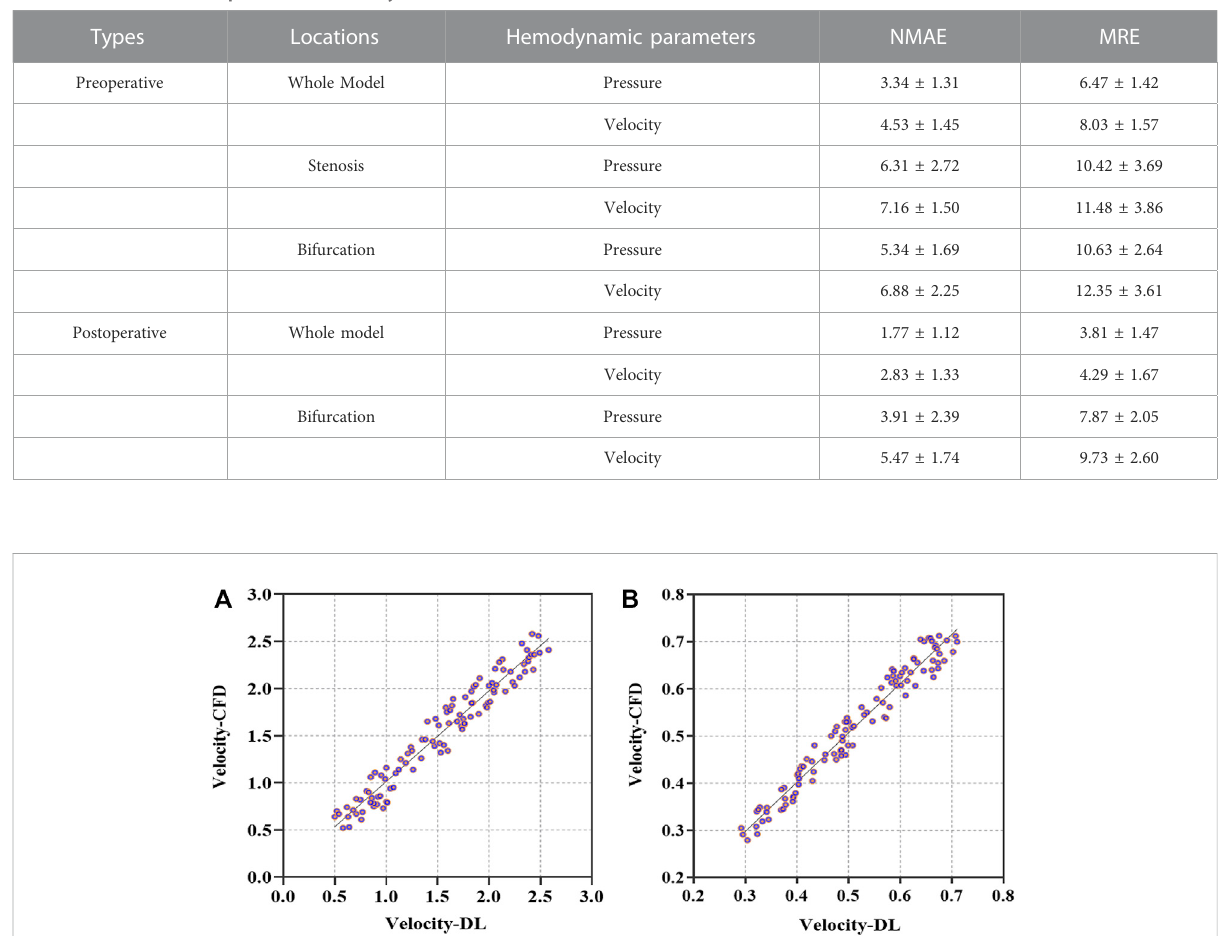
TABLE 3 Error functions of pressure and velocity fi elds.